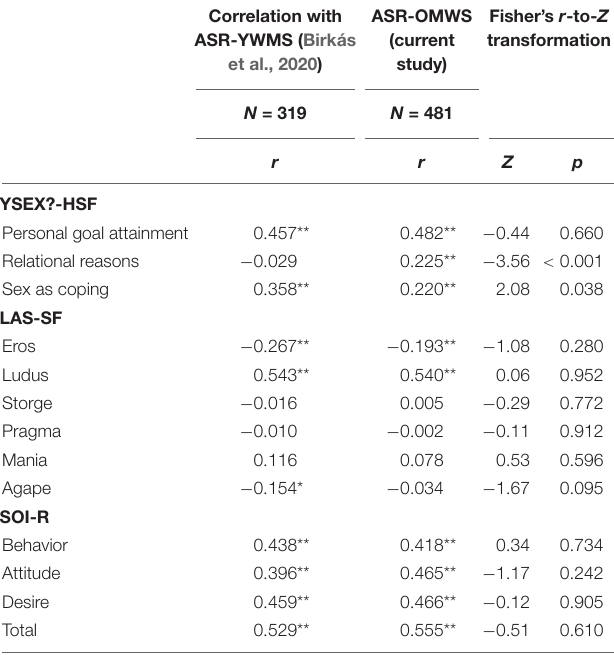
TABLE 2 | Pearson’s correlations between acceptance of sugar relationships and sexual motivation, sociosexuality, and love attitudes (sample 1). Correlation with ASR-YWMS